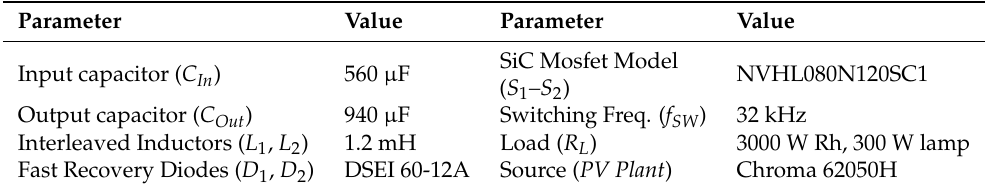
Table 2. Experimental Circuit Parameters.